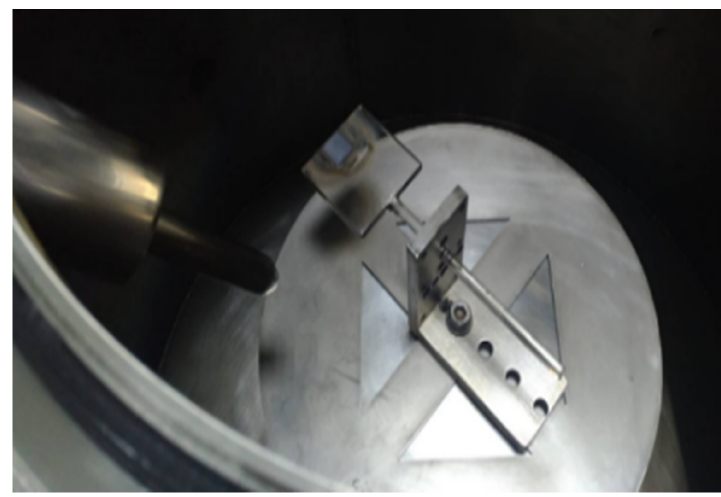
Figure 9. Photo image of the sample holder stage and antenna.